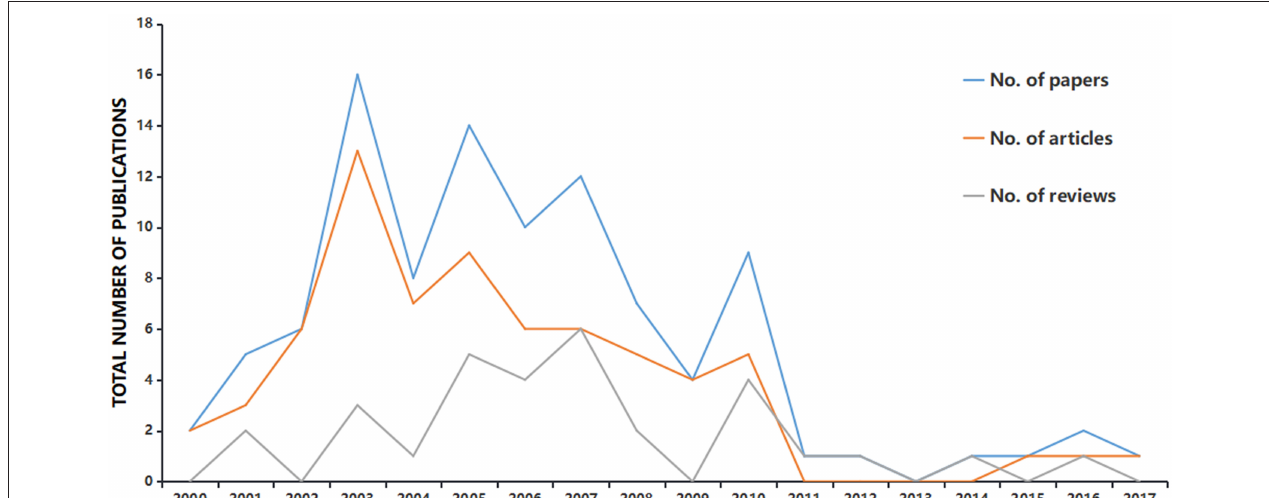
FIGURE 2 | Number of publications among different types of articles according to publication year.